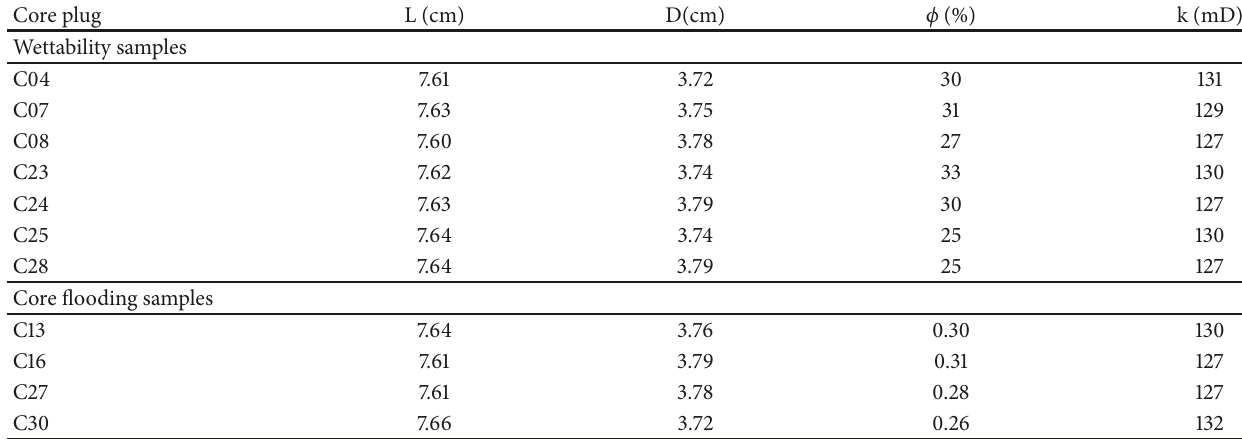
Table 2: Basic properties of core plugs.